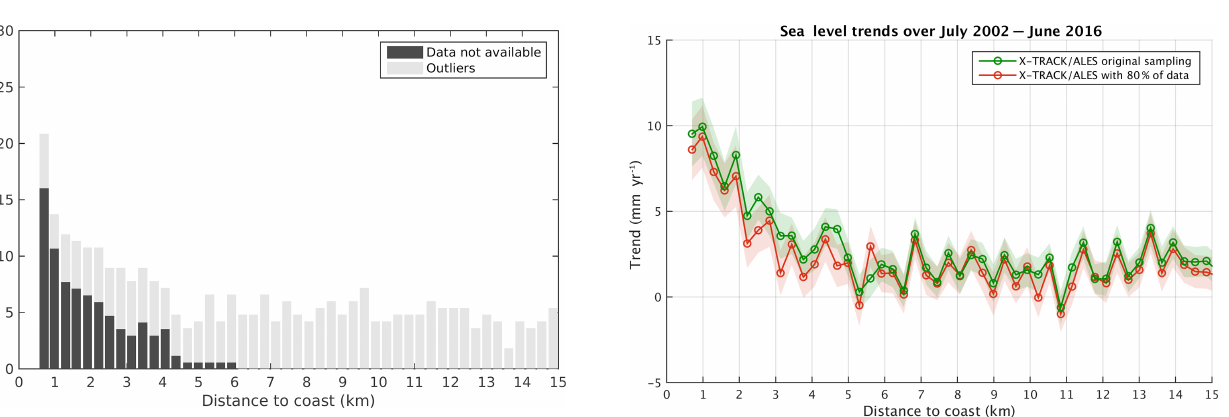
Figure 7. Sea level trends against the distance to the coast with the original data set (green curve) and new sampling (80% of original data kept; red